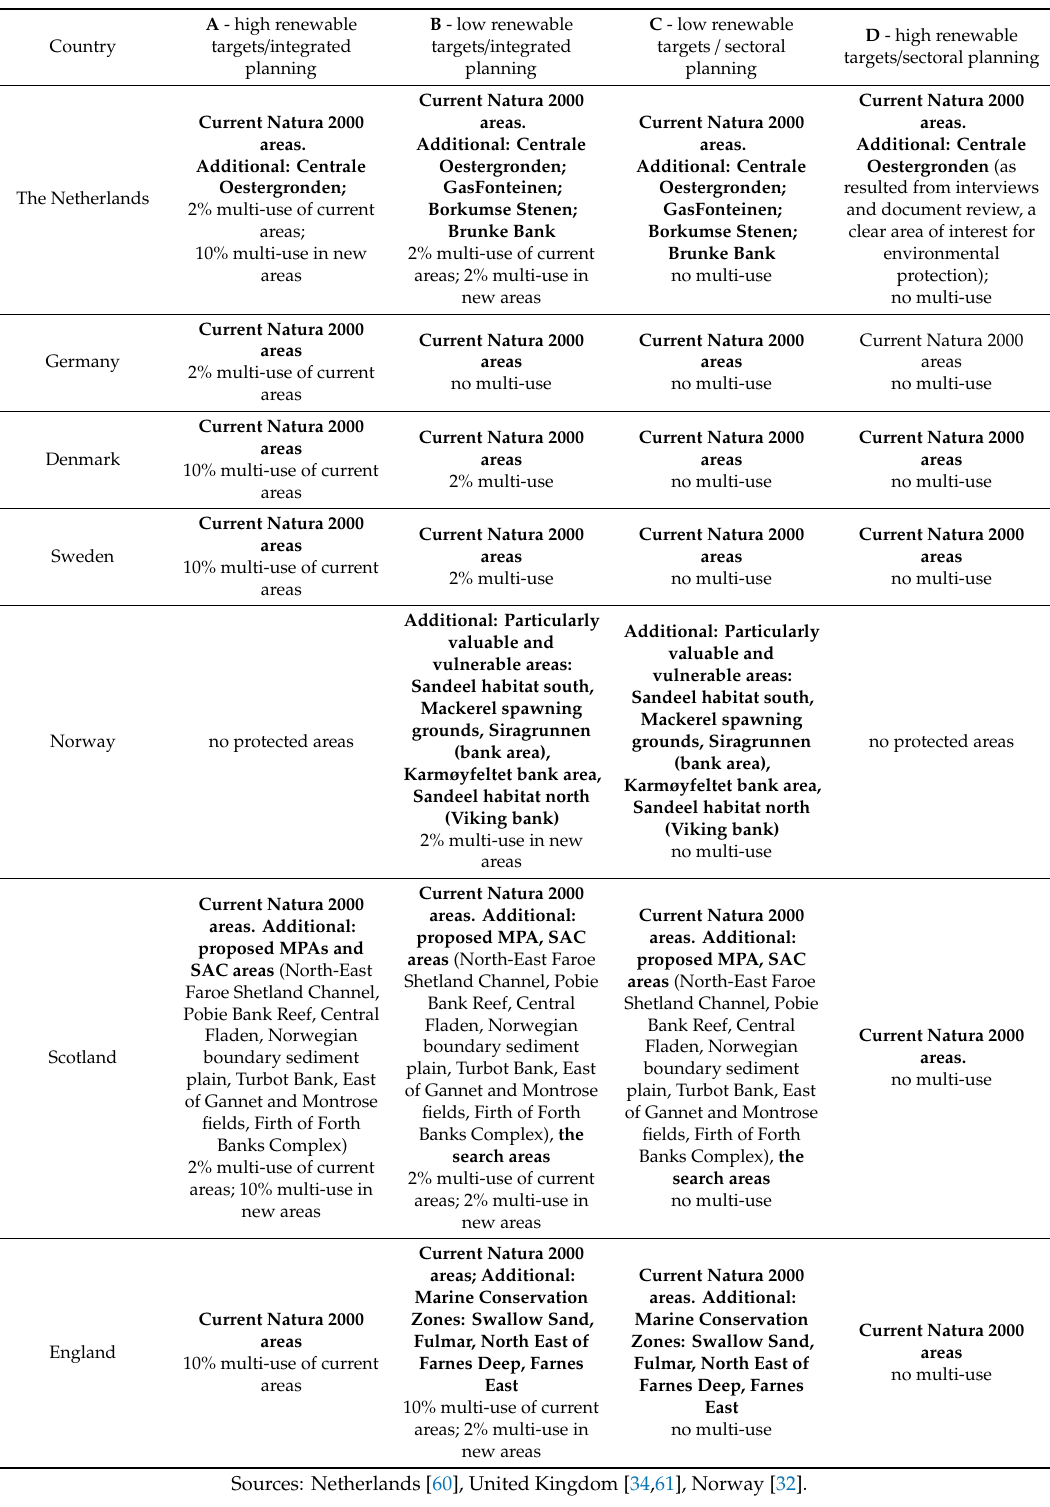
Table A5. Assumptions for the interaction with protected marine environment / scenarios. The percentages for the quantification of the potential multiple use of space are proposed according to current practices (approximately 10% for England, approximately 2% for